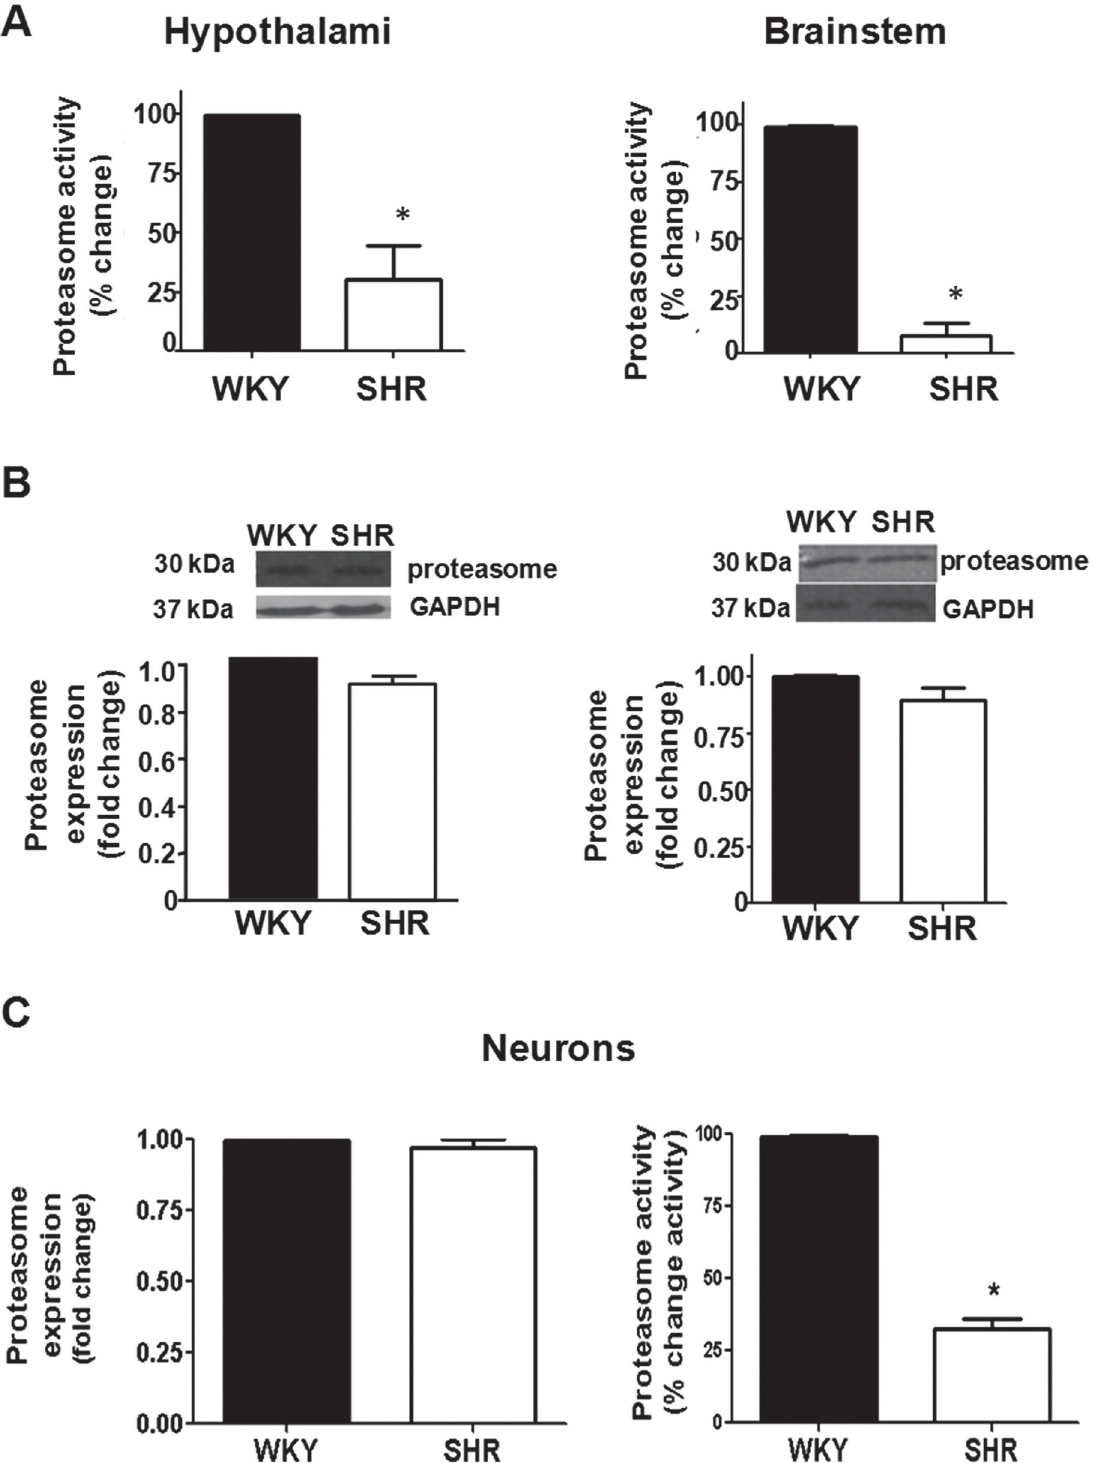
Fig 8. A, Proteasome activity in the hypothalamus and brainstem of WKY and SHR rats. Values are mean ± SEM (n = 7). * P < 0.05 as compared with WKY. B, Proteasome protein level in the hypothalamus and brainstem, respectively, from WKY and SHR. Proteasome protein level was measured by Western-blot as described under Methods. Blots were stripped and reprobed for GAPDH to assess protein loading. Signals from proteasome protein level were normalized to GAPDH levels. Values are mean ± SEM (n = 7). * P < 0.05 as compared to WKY. C, Proteasome protein level and activity in neuronal cultures from the hypothalamus and brainstem of WKY and SHR rats. Values are mean ± SEM of 3 determinations from three separate cell culture preparations. * P < 0.05 as compared with